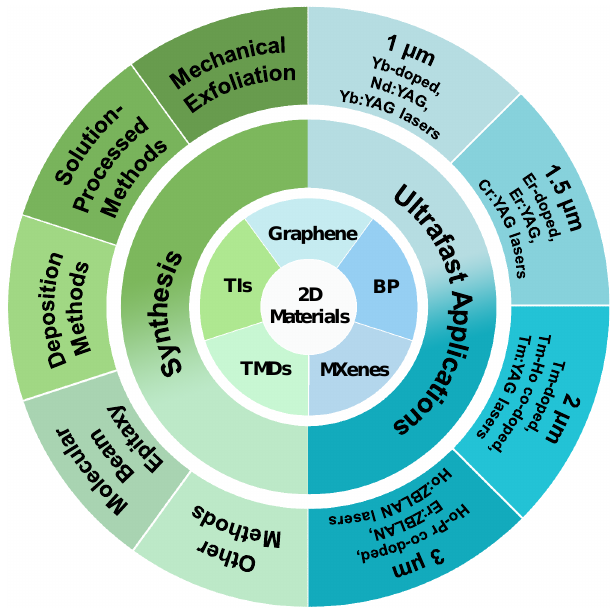
Figure 1. Synthesis and ultrafast applications of 2D materials.